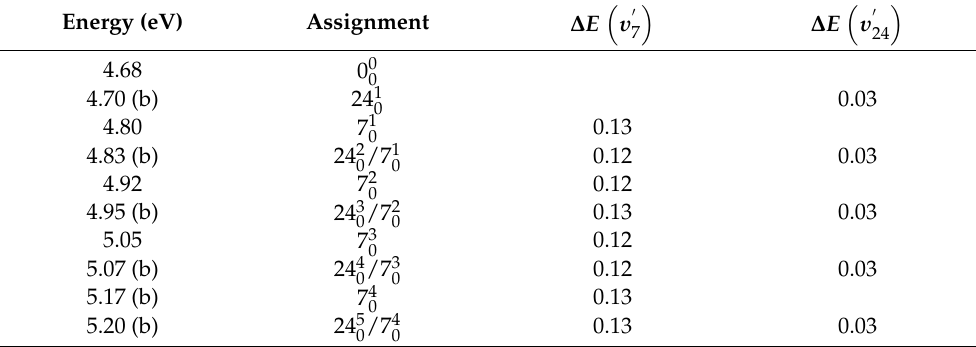
Table 4. Proposed vibrational assignments in the 4.6 − 5.4 eV absorption band of 5BrPyr (Band II). ∆ E (in eV) represents the energy of one extra quanta in the vibrational progression. The symbol “/” means both modes are